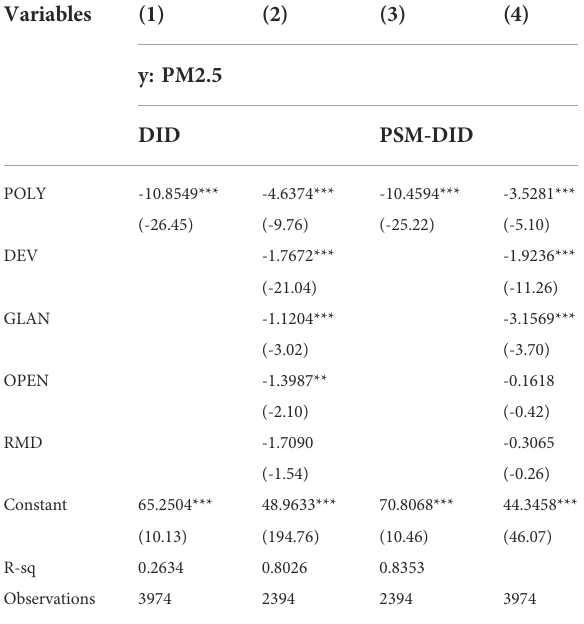
TABLE 8 Regression results of DID and